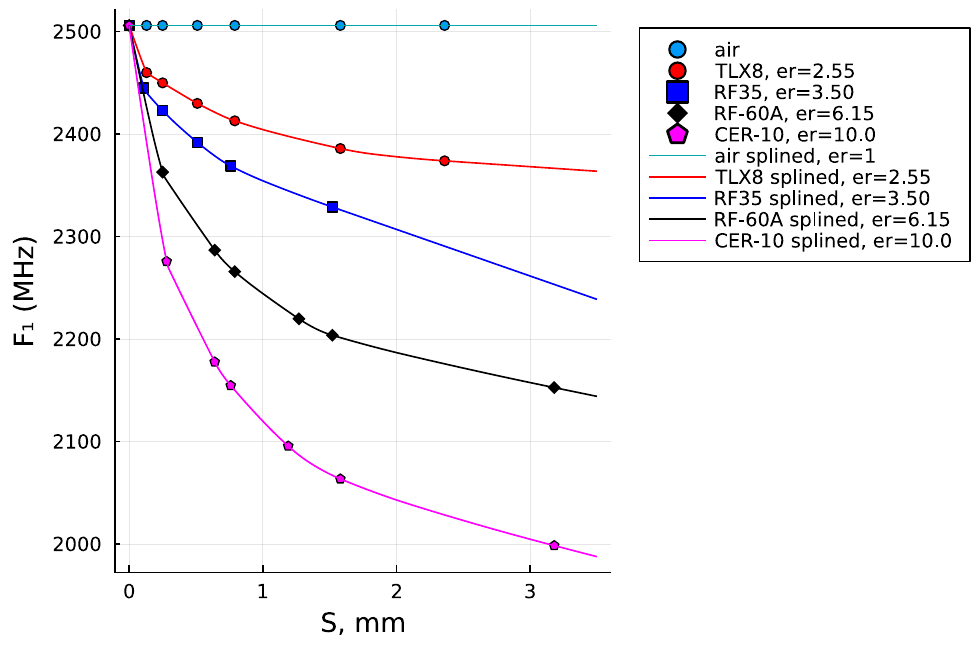
Figure 4. The reference points interpolated by a Schumaker spline shape-preserving algorithm in Julia programming language.